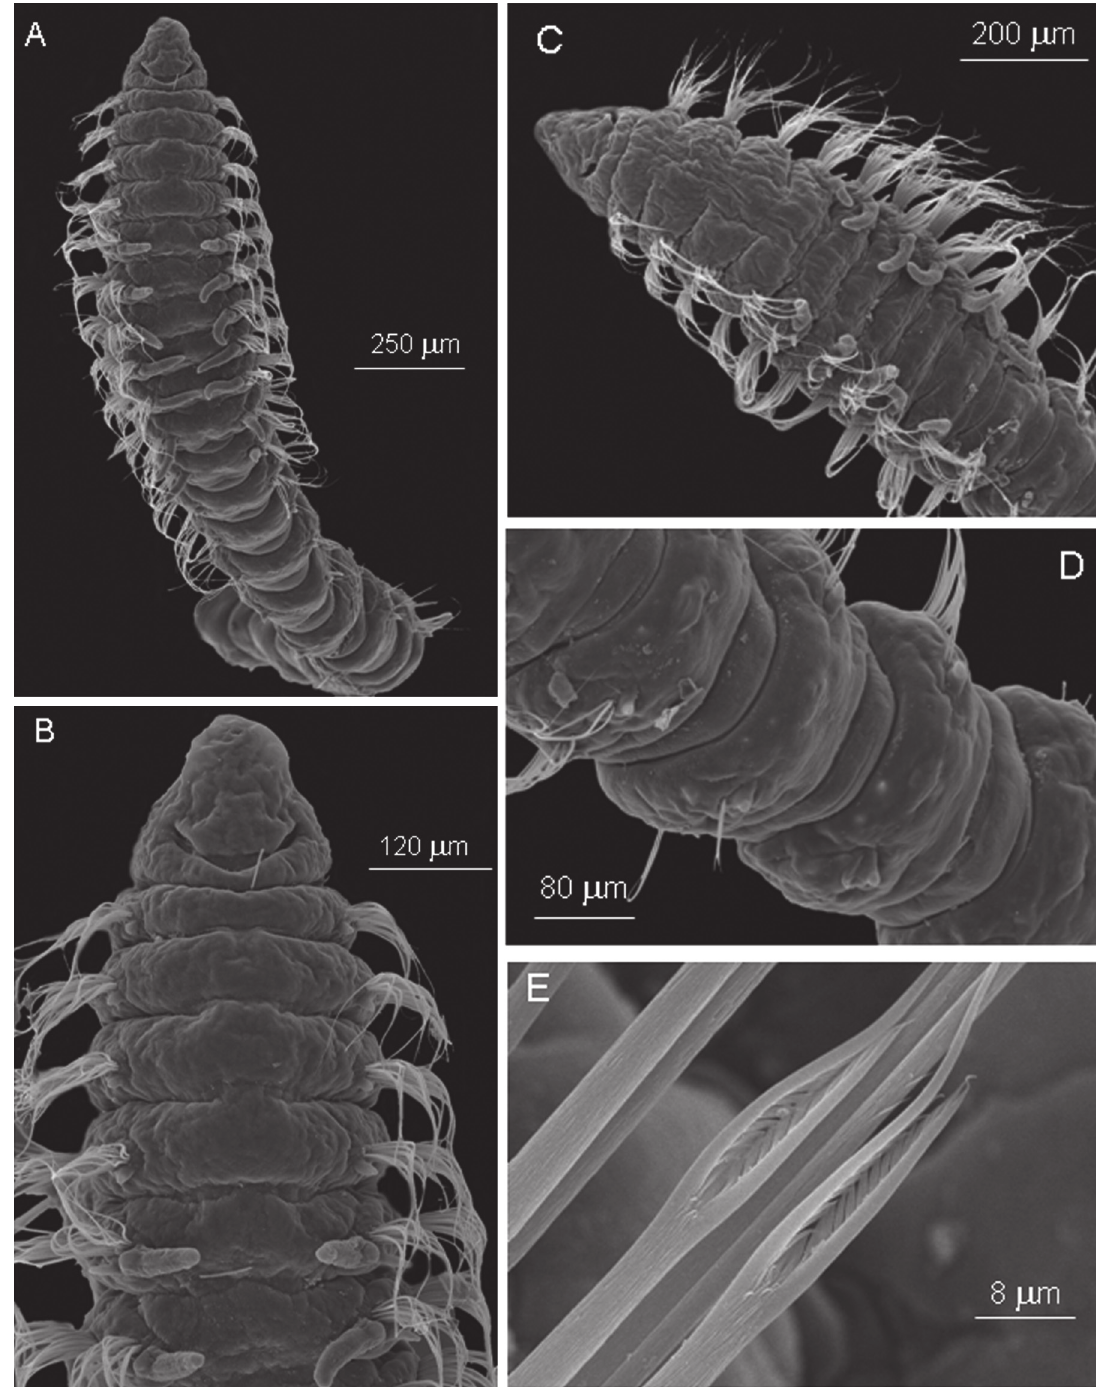
Fig . 13. – Paradoneis mikeli n. sp.: A, dorsal view; b, anterior region, dorsal view; c, anterior region, dorsal view; D, postbranchial region, dorsal view, showing mid-dorsal folds; e, posterior modified neurochaetae. Scale bar: A 250 µ m; b 120 µ m; c 200 µ m; D 80 µ m; e 8 µ